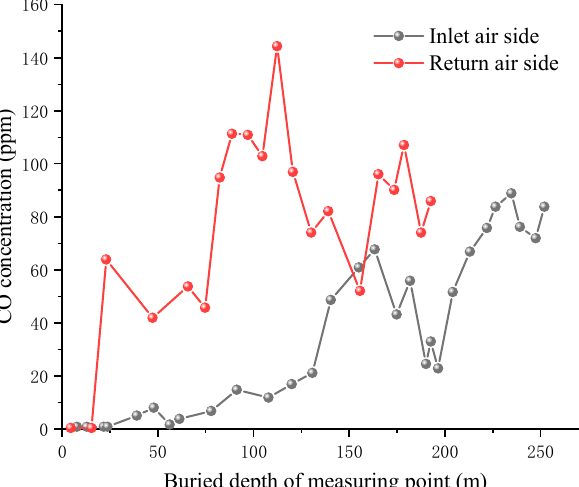
Figure 4. Distribution of CO concentration at measuring points on the return air and the inlet air side. three zones of SC in the goaf are divided according to the oxygen concentration of 8.0%